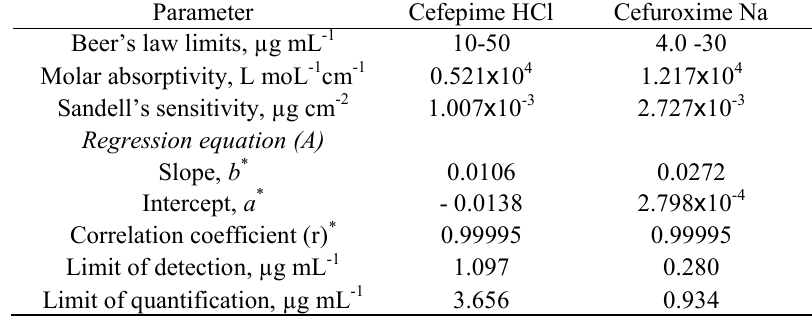
Table 2. Optical characteristics for the reaction of cited drugs with triphenyltetrazolium chloride